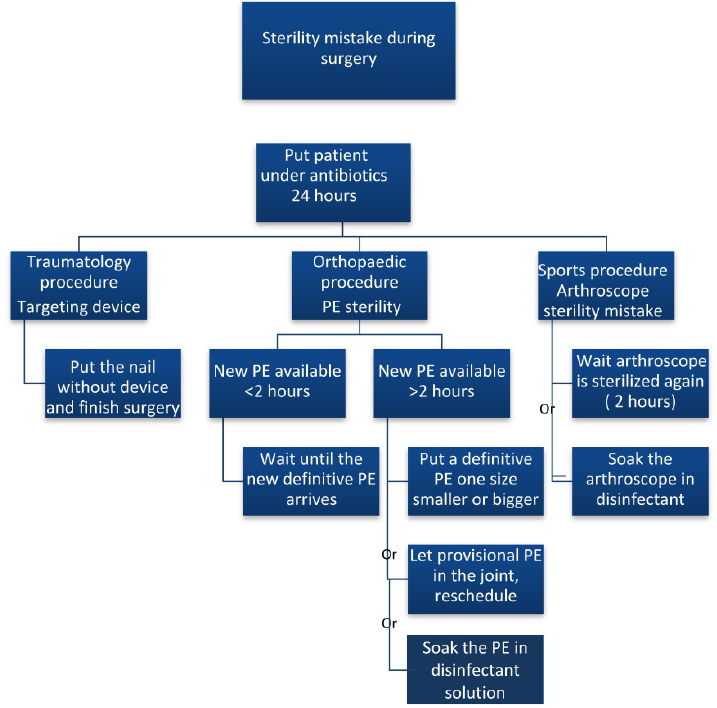
most Figure 6. Decision tree based on experienced surgeons’